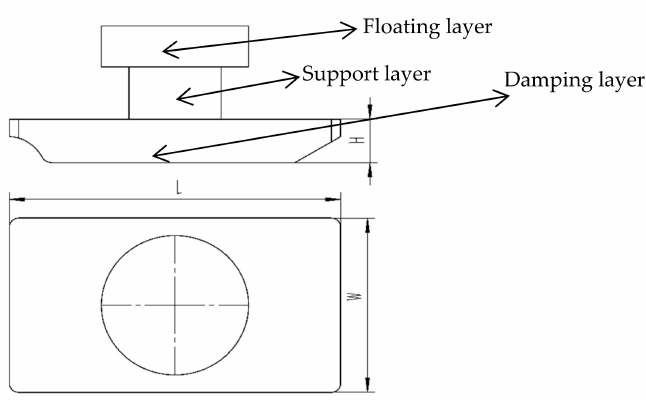
Figure 1. Semi-submerged multi-buoy wave energy converter (WEC).